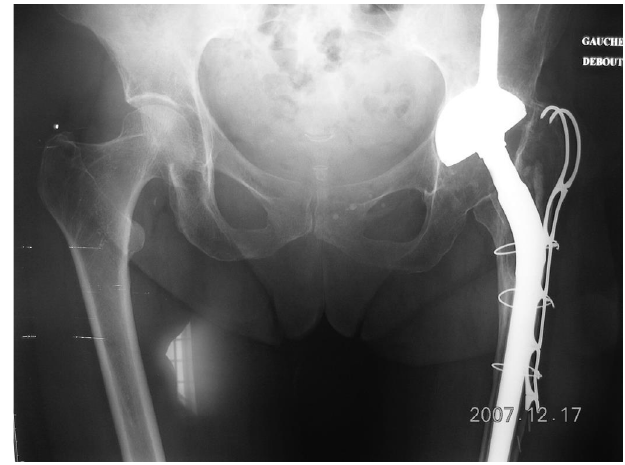
Figure 5. ETO fi xed by MRP Integra, complete healing of the osteotomised fragment at 1 year.